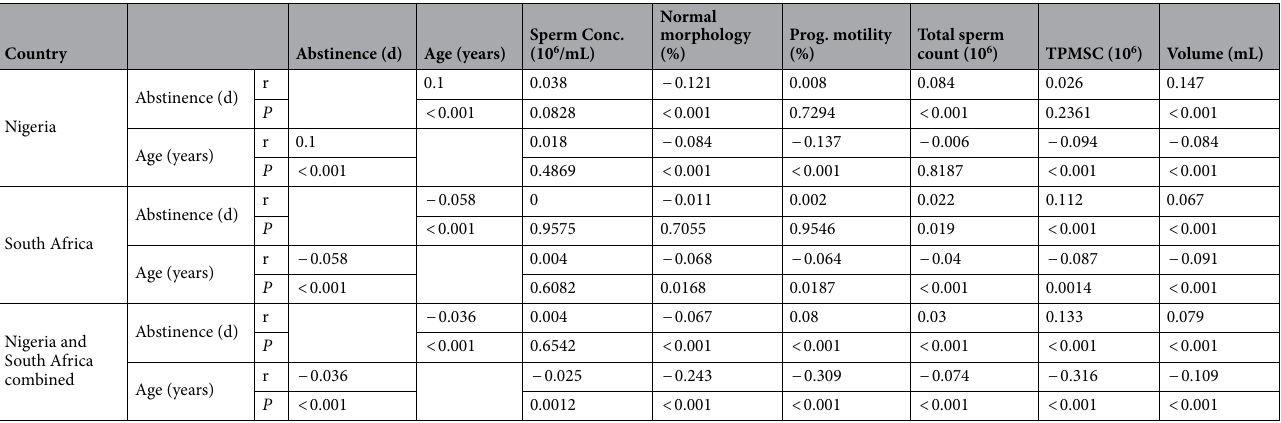
Table 4. Spearman rank correlations for various parameters in Nigeria, South Africa and for the data of these countries combined.